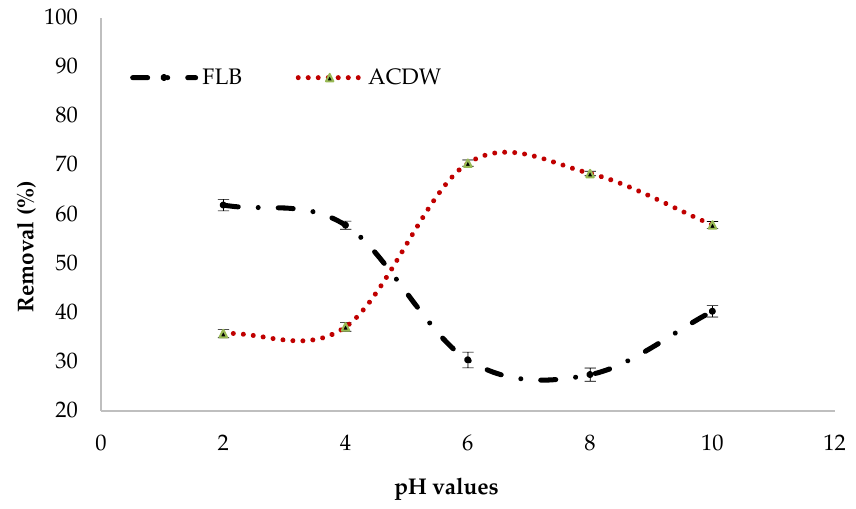
Figure 7. Influence of pH values on elimination efficiency of IV2R dye.